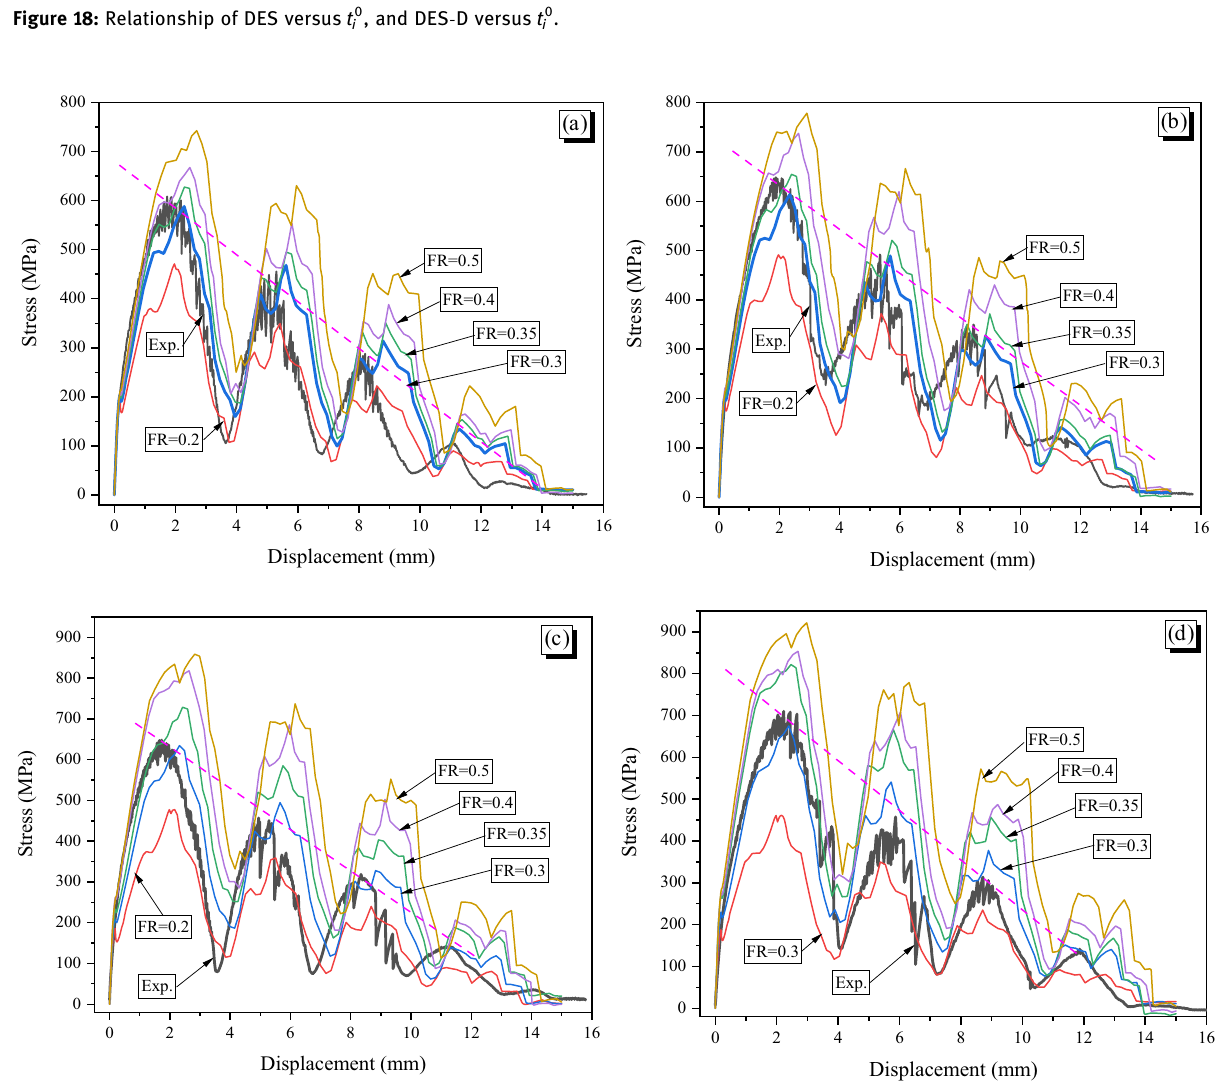
Figure 19: Pullout stress versus displacement curves of crimped fi ber in FEA and experimental test: ( a ) CR1, ( b ) CR2, ( c ) CR3, and ( d )